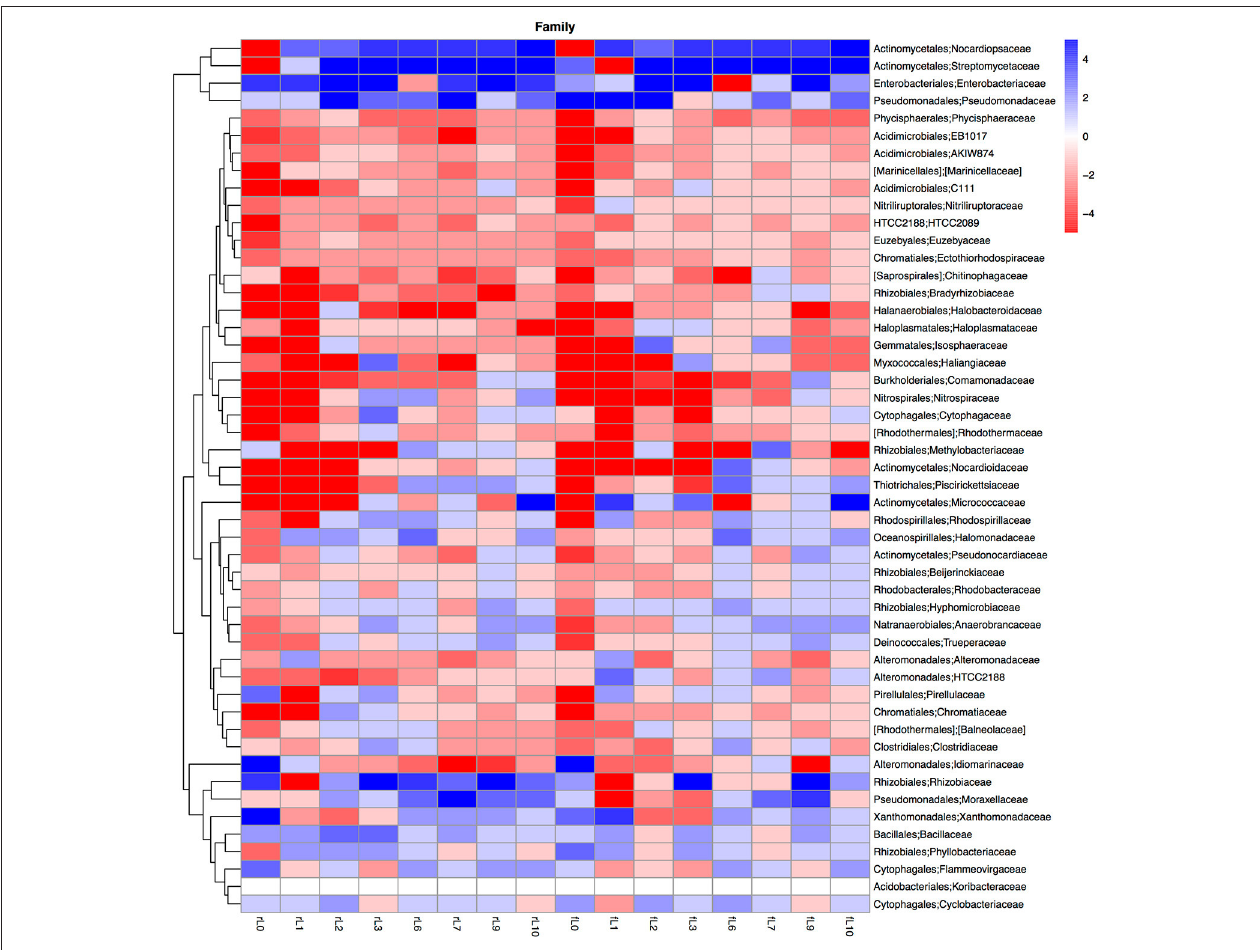
FIGURE 10 | Heatmap of the ratio between the relative abundance of the different bacterial families in the unamended soil vs. the soil amended with maize plantlets or its neutral detergent fiber (NDF). Legends to the figure can be found in Figure 5 .